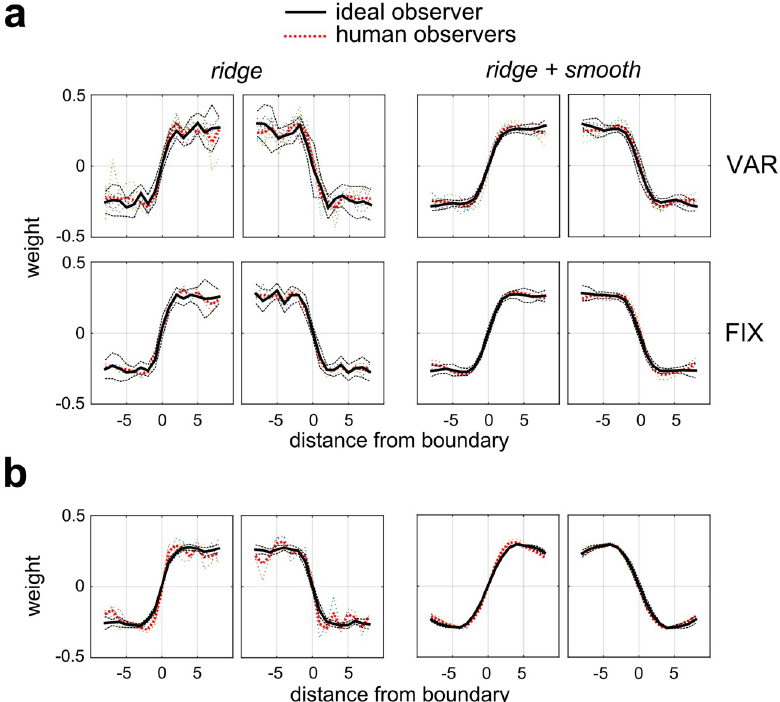
Fig 5. Normalized 1-D profiles of the average second-stage filter weights (30 bootstrapped re-samples). Thick black lines are for the ideal observer, thin black dashed lines indicate confidence intervals (+/- 1.96 SEM). Colored lines indicate normalized profiles for individual human observers. All models used AVG pooling. (a) Experiment 1-VAR (top) and Experiment 1-FIX (bottom). (b) Experiment 1-HFC (higher density of smaller micropatterns).